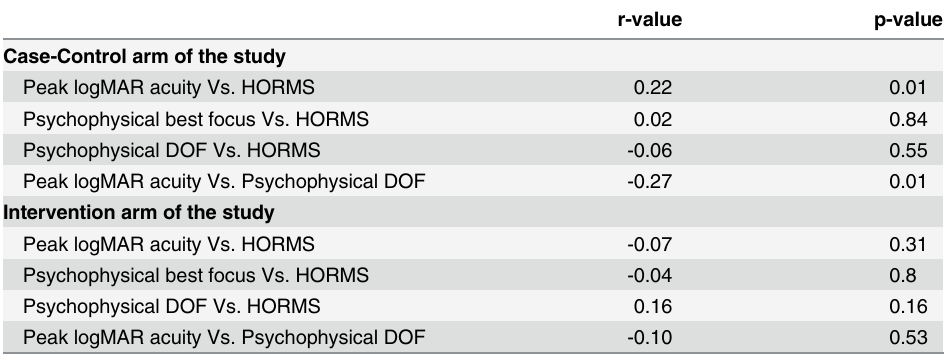
Table 2. Results of the psychophysical analyses performed in the first and second arms of this study. All details are same as Table 1.